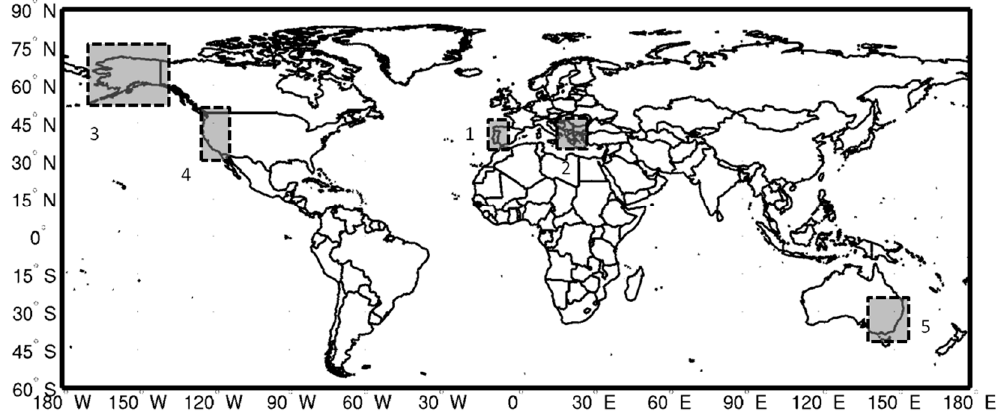
Figure 1. Study areas: ( 1 ) Portugal; ( 2 ) Greece; ( 3 ) Alaska; ( 4 ) California and ( 5 ) SE Australia.